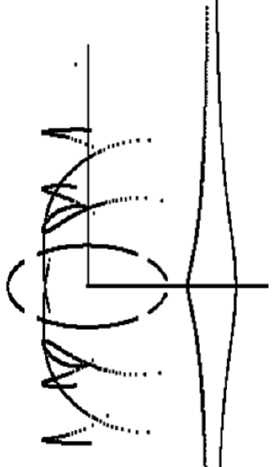
Figure 16. q = 2, KG = 100, and DK = 140.